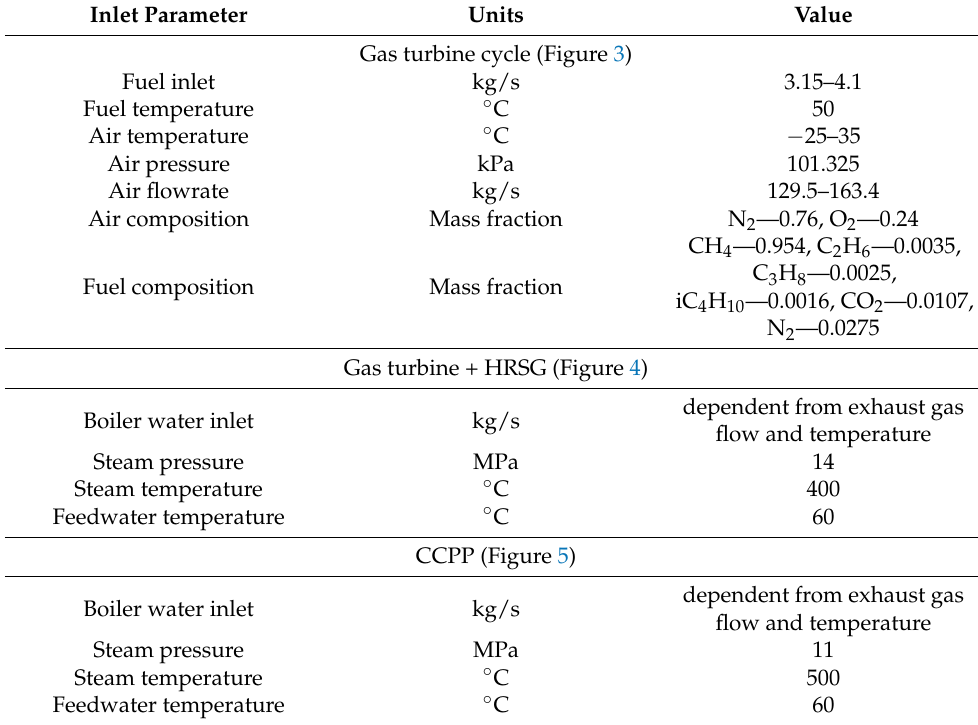
Table 3. Input parameters.